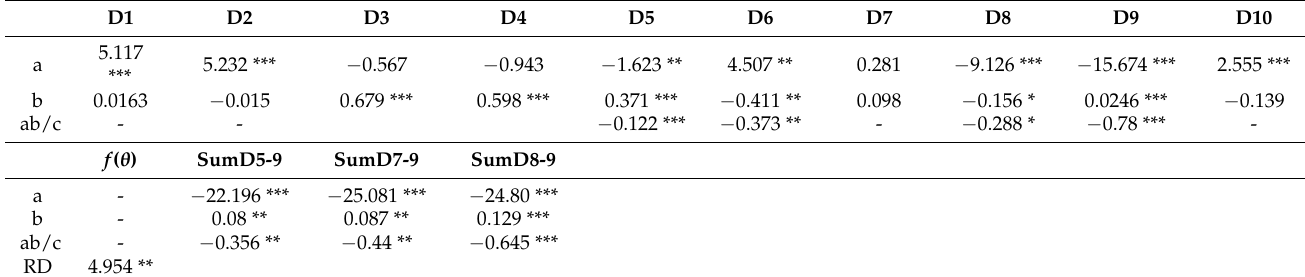
Table 8. Results of the three regressions with Equations (8)–(10) from the mediation analysis of angular effects; the coefficients of the clump fixed-effect dummy variables are not